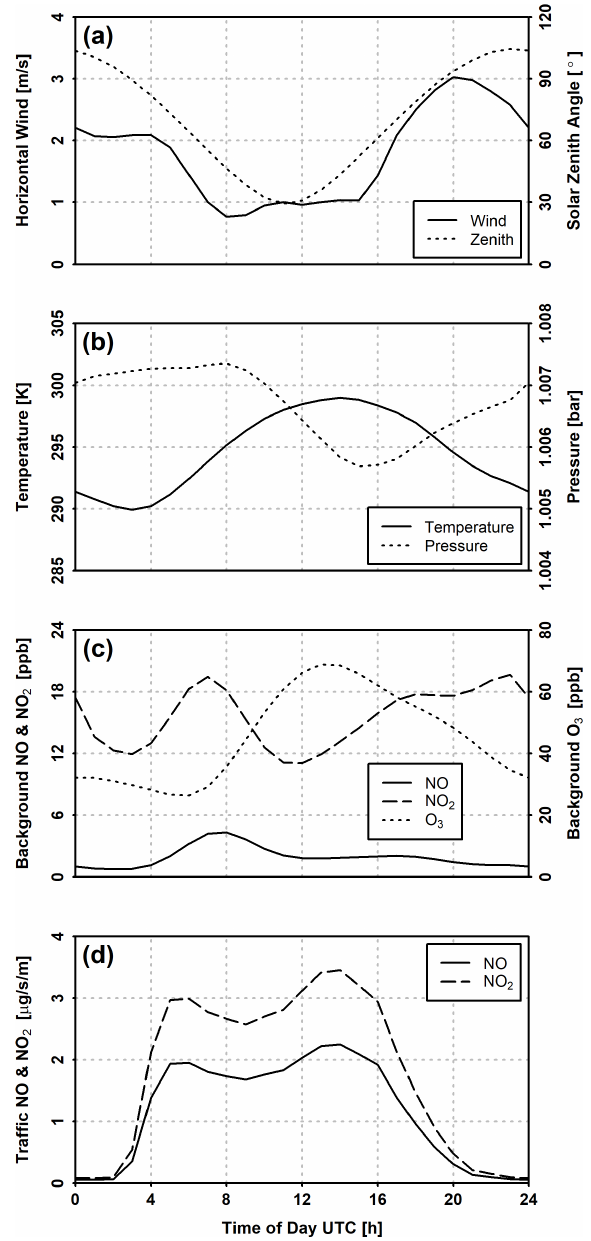
Figure 6. Prescribed conditions for the transient simulation: (a) horizontal freestream wind velocity and solar zenith angle; (b) ambient temperature and density; (c) urban background NO, NO 2 , and O 3 concentrations; and (d) workday traffic NO and NO 2 emissions per unit street section